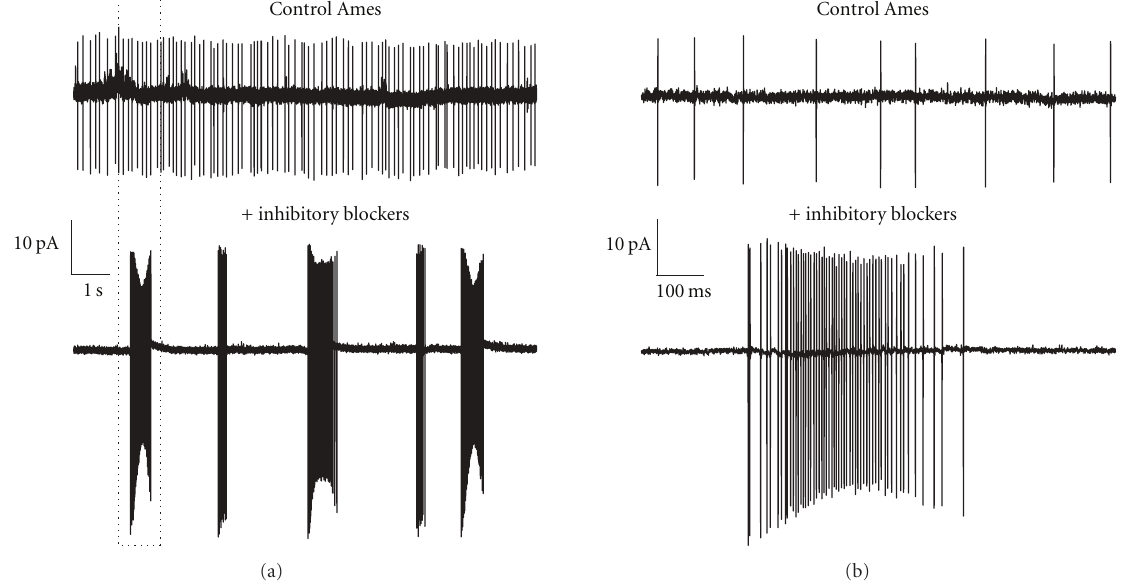
Figure 3: Loose patch extracellular recording of spontaneous spike activity from wild-type (non-dystrophic) retinal ganglion cell perfused with Control Ames solution without (top traces (a) and (b)) and with (lower traces (a) and (b)) the addition of mixture of inhibitory synaptic blockers containing 40uM Gabazine, 50 uM TPMPA, and 1uM Strychnine. Boxed region outlined by the dash lines in (a) are shown on a faster time in (b). The trace shown on an expanded time scale in control Ames (b) was taken from a region of trace in (a) that was shifted to the right to avoid the period of baseline